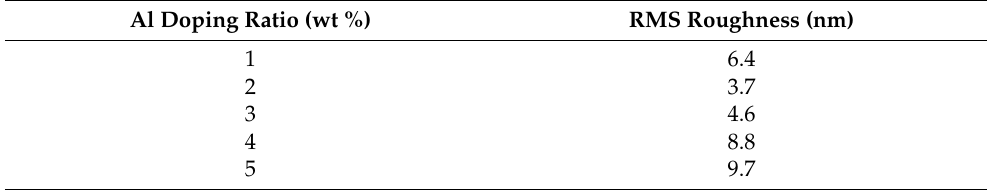
Table 2. The RMS roughness of AZO films .